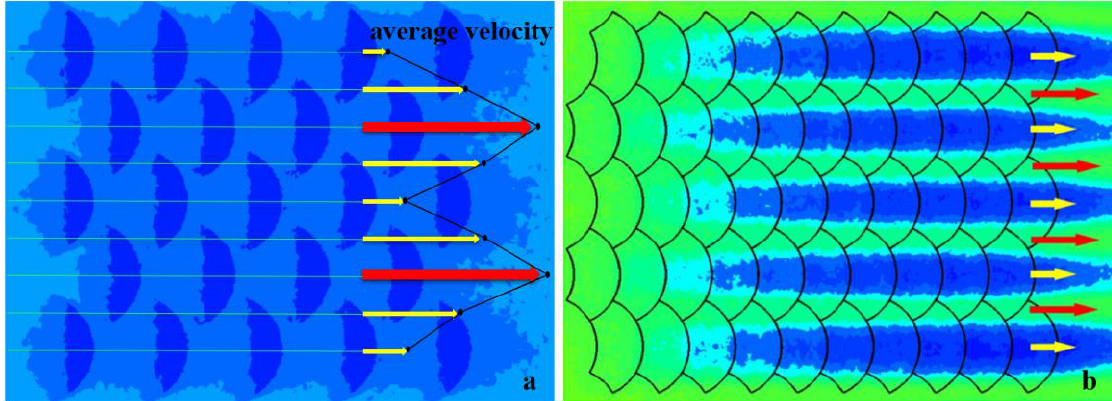
Figure 21. Velocity distribution on the bionic surface. ( a ) The result of this research; ( b ) The result of Muthuramalingam,